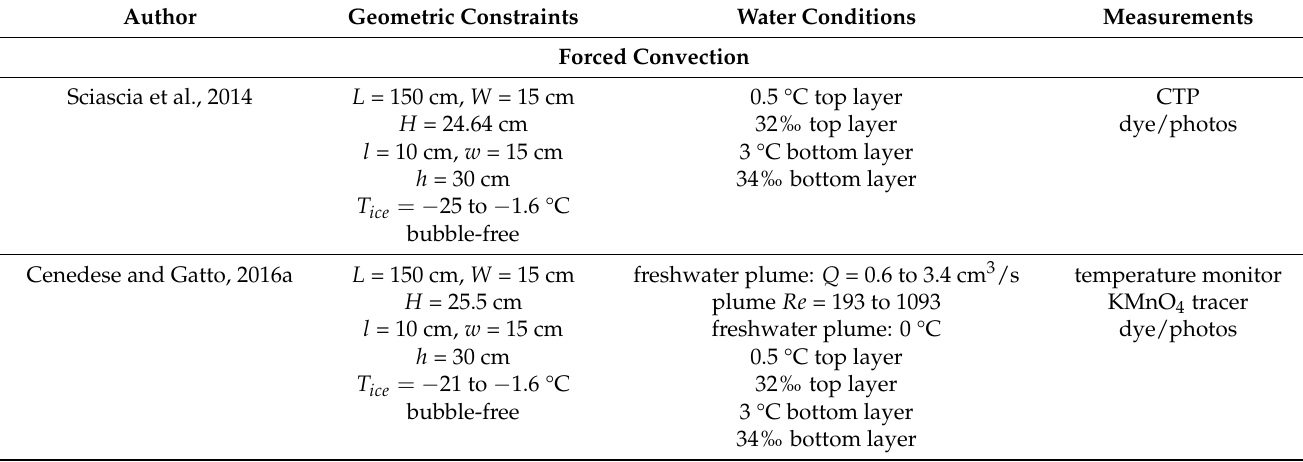
Table A4. Experiments focused on flow patterns and melting at the face of a vertical ice wall in forced